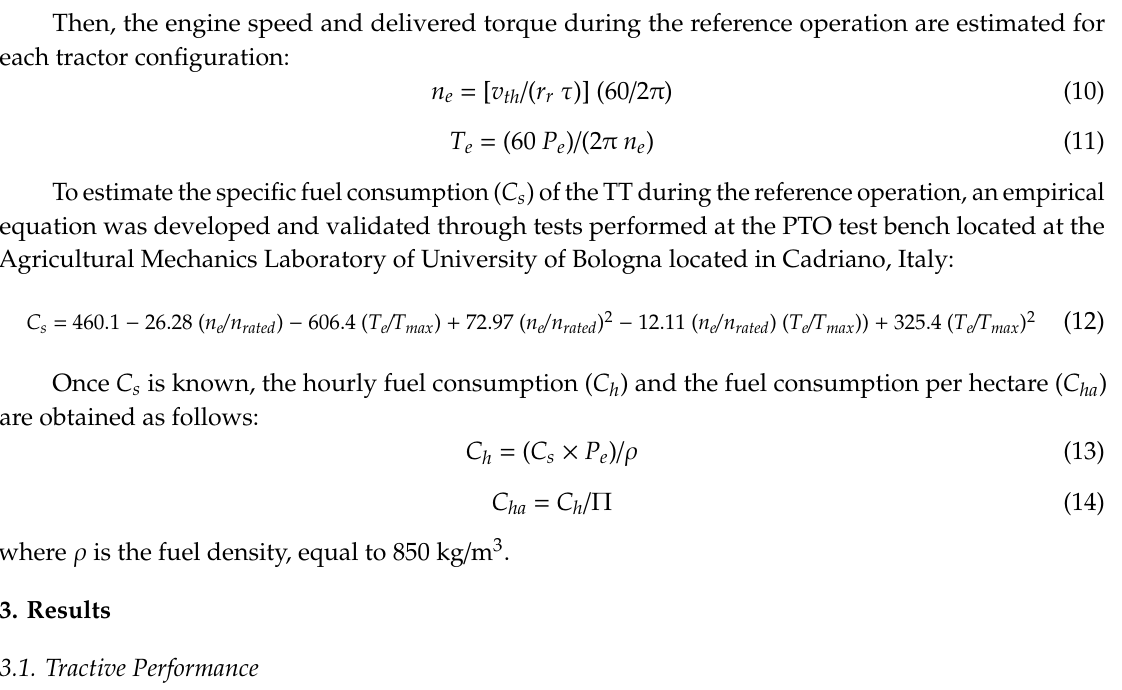
Figure 6. Example of the tractor slip estimation starting from the expected value of F Dplough . Tractor configuration FC and 8th